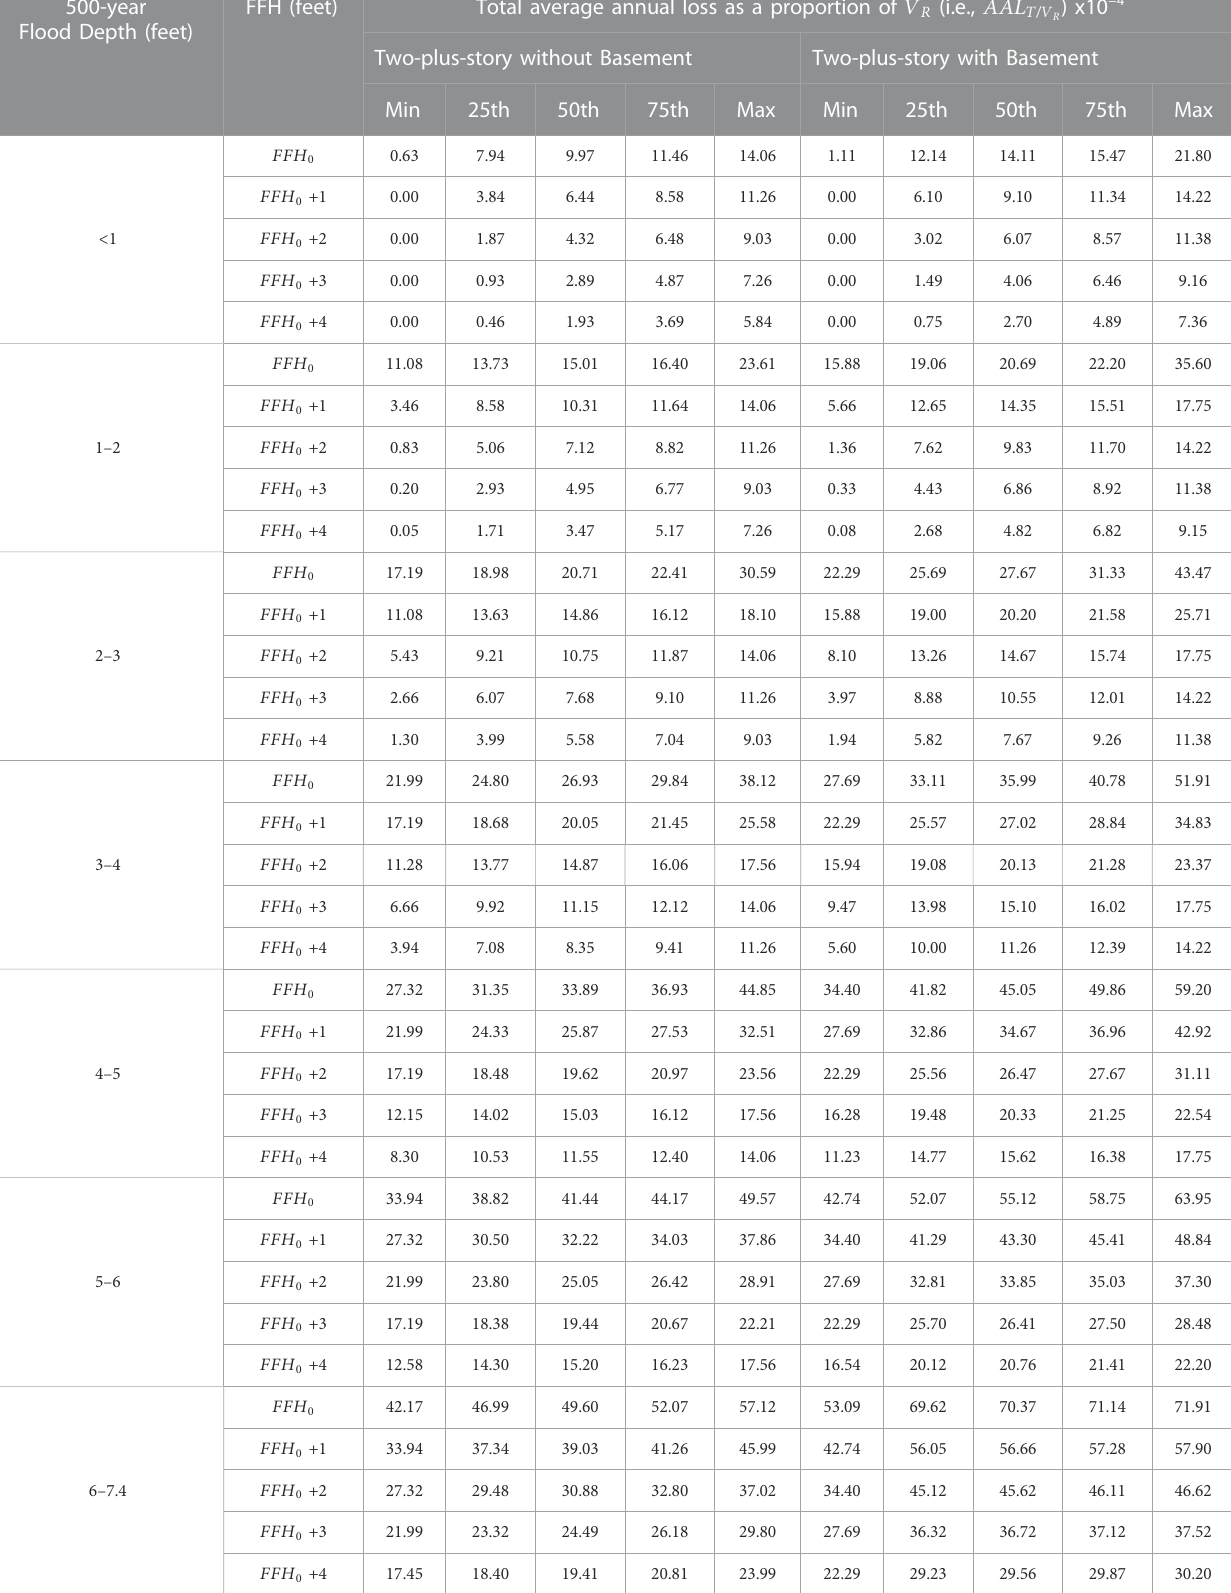
TABLE 4 As in Table 3, except for two-plus-story home. 500-year Flood Depth